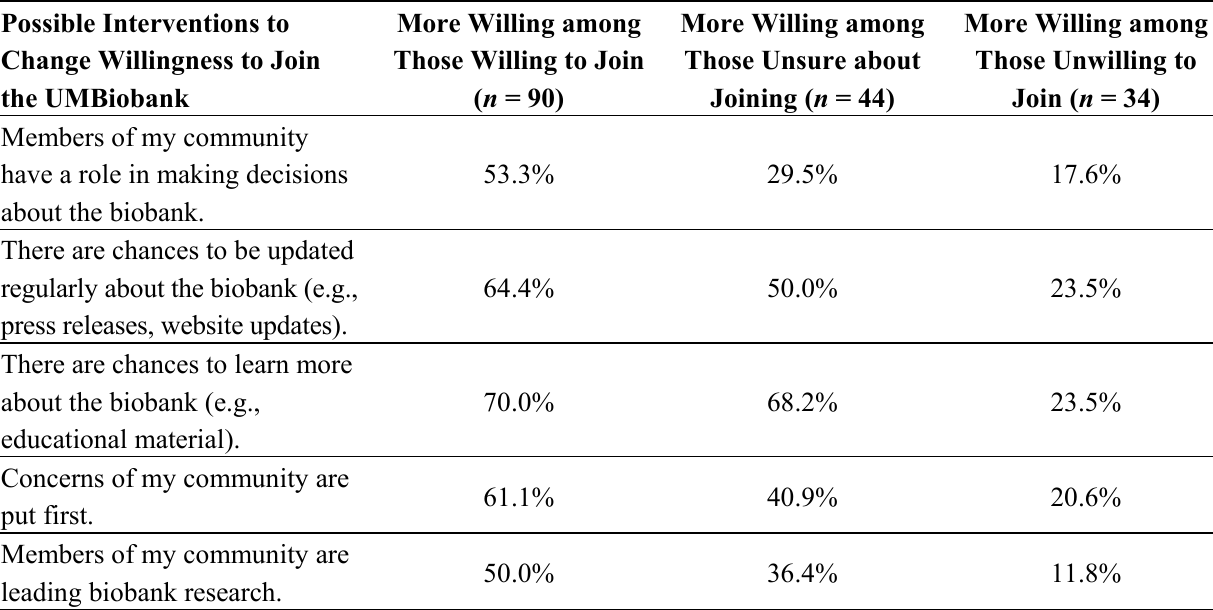
Table 5. Willingness to join according to perceived responsiveness to approaches to engage the community and to build trust in